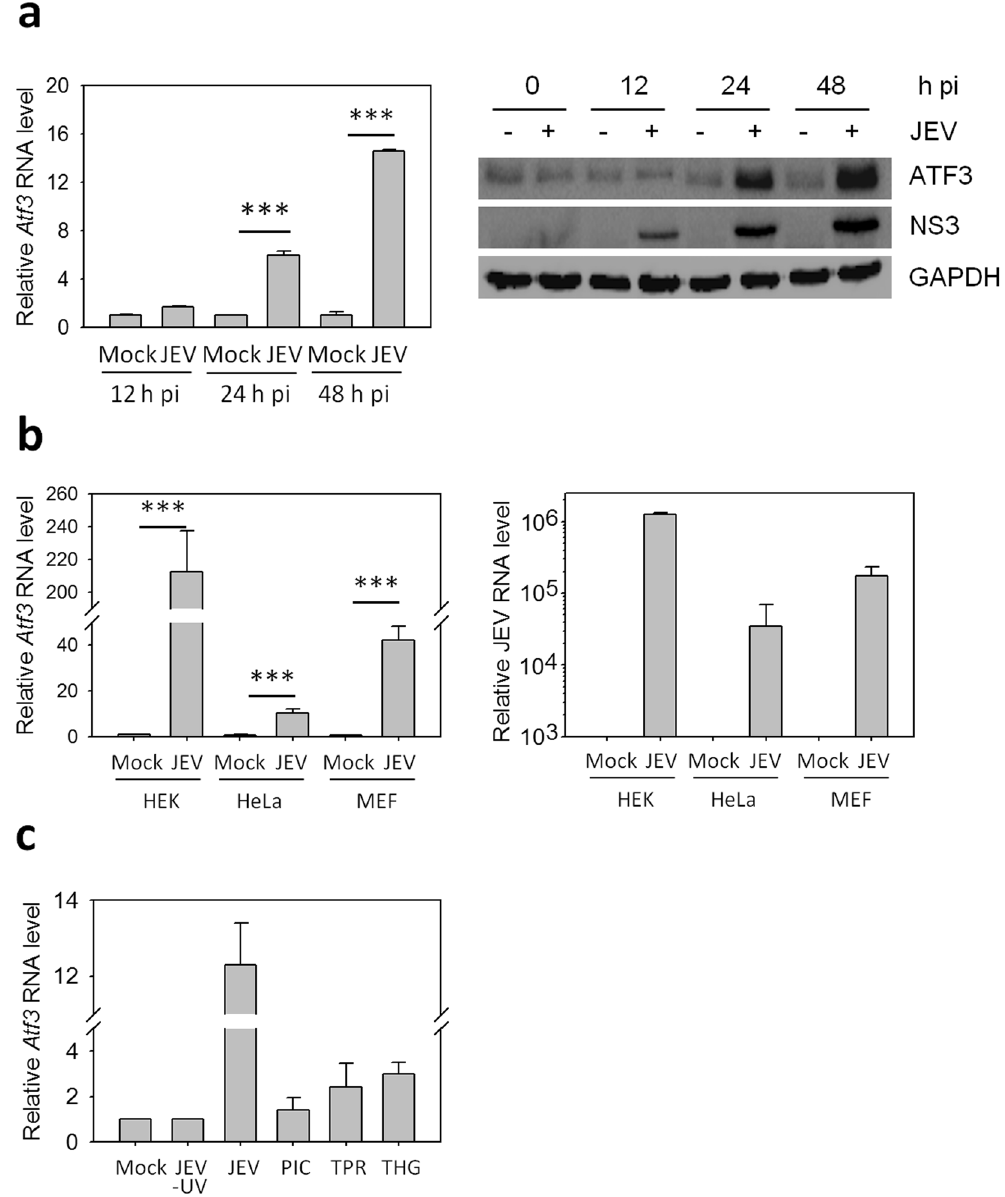
Figure 1. ATF3 induction in mammalian cells during JEV infection. ( a ) Neuro2a cells were mock-infected or infected with JEV (MOI 5) and at different times post-infection (pi) cells were harvested to isolate total RNA and proteins. qRT PCR was performed to quantitate the Atf3 expression. Relative abundance of Atf3 transcript at various time points is shown (left panel). The cell lysates were Western blotted to study the relative amounts of ATF3 following the virus infection that was monitored by the presence of the JEV NS3 protein (right panel). ( b ) Mammalian cells were mock-infected or infected with JEV (MOI 5). Relative levels of Atf3 transcripts were determined by qRT PCR in various cell lines 24 h pi (left panel). The infection of cells with JEV was established by qRT PCR for JEV genomic RNA (right panel). ( c ) Neuro2a cells were incubated with UV-inactivated JEV (JEV-UV) or infected with JEV (MOI 5), or transfected with 1 µ g poly(IC) (PIC) or triphosphate RNA (TPR), or treated with 1 µ M thapsigargin (THG). Total RNA was isolated from these cells 24 h later, and qRT PCR was performed to quantitate the Atf3 expression. The relative abundance of Atf3 transcript is shown after various treatments. The Gapdh levels were used for normalization. All the experiments were performed in triplicates on three different occasions. The statistical significance of the difference between the data was established by Student’s t-test; * p < 0.05; ** p < 0.01; *** p <